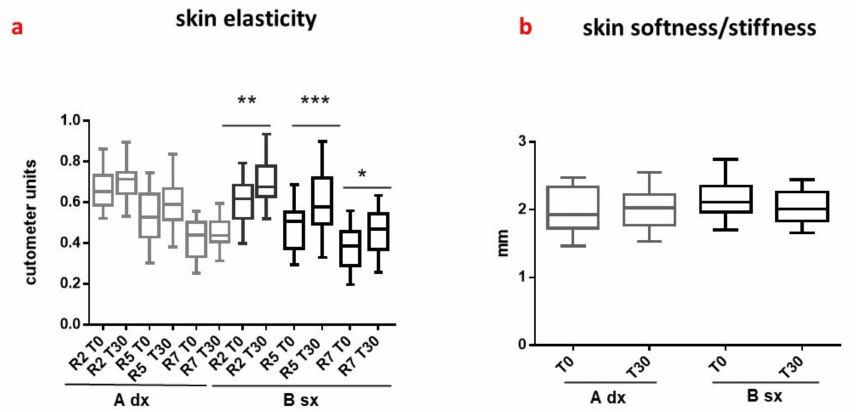
Figure 9. Skin elasticity data ( a ) and skin firmness values ( b ) recorded at time 0 (T 0 , before the application of A and B) and after 30 days (T 30 ) of treatment. Results shown are mean ± SD of three determinations for each volunteer at different measurement times. Data were analyzed by two-way RM (repeated measures) ANOVA (analysis of variance), followed by a Bonferroni adjustment. Data were significant different p value < 0.05 ( p < 0.05 *; p < 0.01 **; p < 0.001 ***).